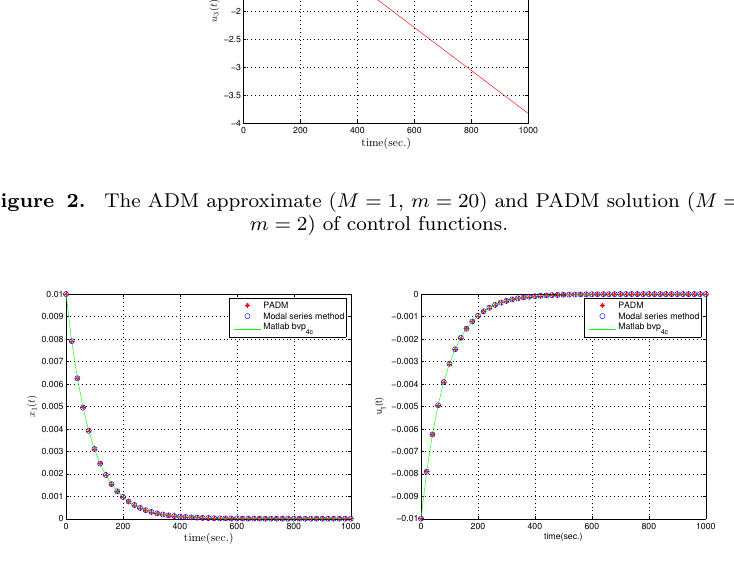
Figure 3. Comparison the bvp4c , modal series method and PADM ( m = 2, M = 50) approximate solution of x 1 ( t ), u 1 ( t ).